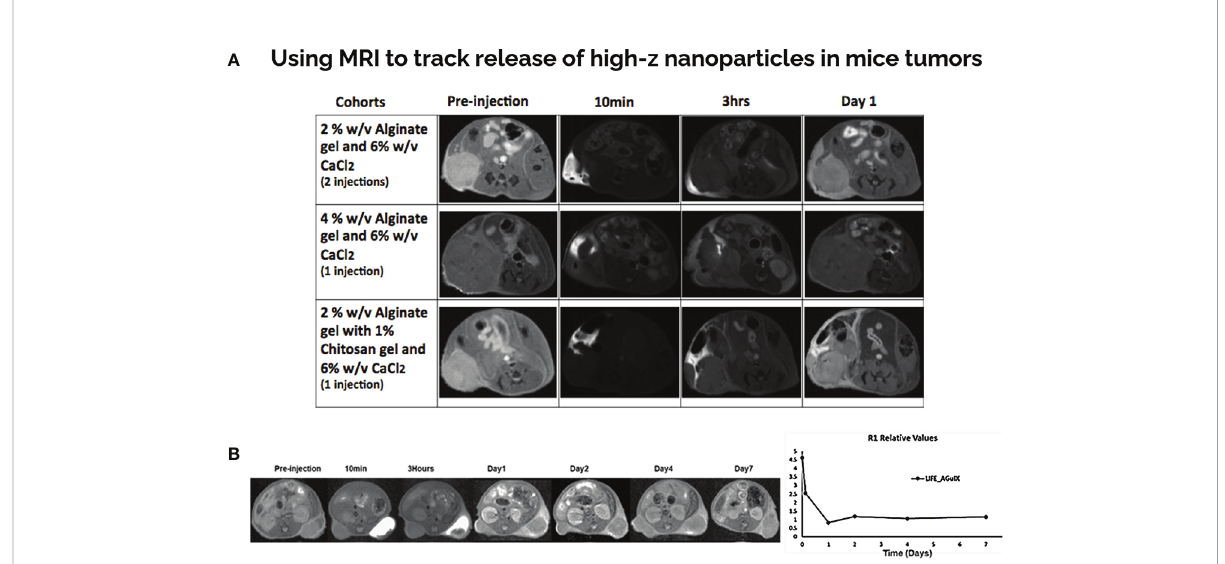
FIGURE 2 LIFE Biomaterial with gadolinium-based nanoparticles show MR contrast over time in mice pancreatic tumors. (A) Different formulations of LIFE gel was tested in the search of prolonging the MR signal for more than 24hrs. (B) LIFE biomaterial was produced using 4% (w/v) (v = 50uL) of sodium alginate biomaterial mixed 1:1 ratio with 1% (w/v) (v = 50 uL) of chitosan biomaterial. 10 uL of AGuIX (c = 4.1 mg/mL) nanoparticles was added to the mixture. MR images showed gadolinium contrast from LIFE biomaterials injected in mice pancreatic tumors up to 7-days post injection. Plot shows relaxation values corresponding to gadolinium contrast remaining in the tumor microenvironment for up to 7-days post